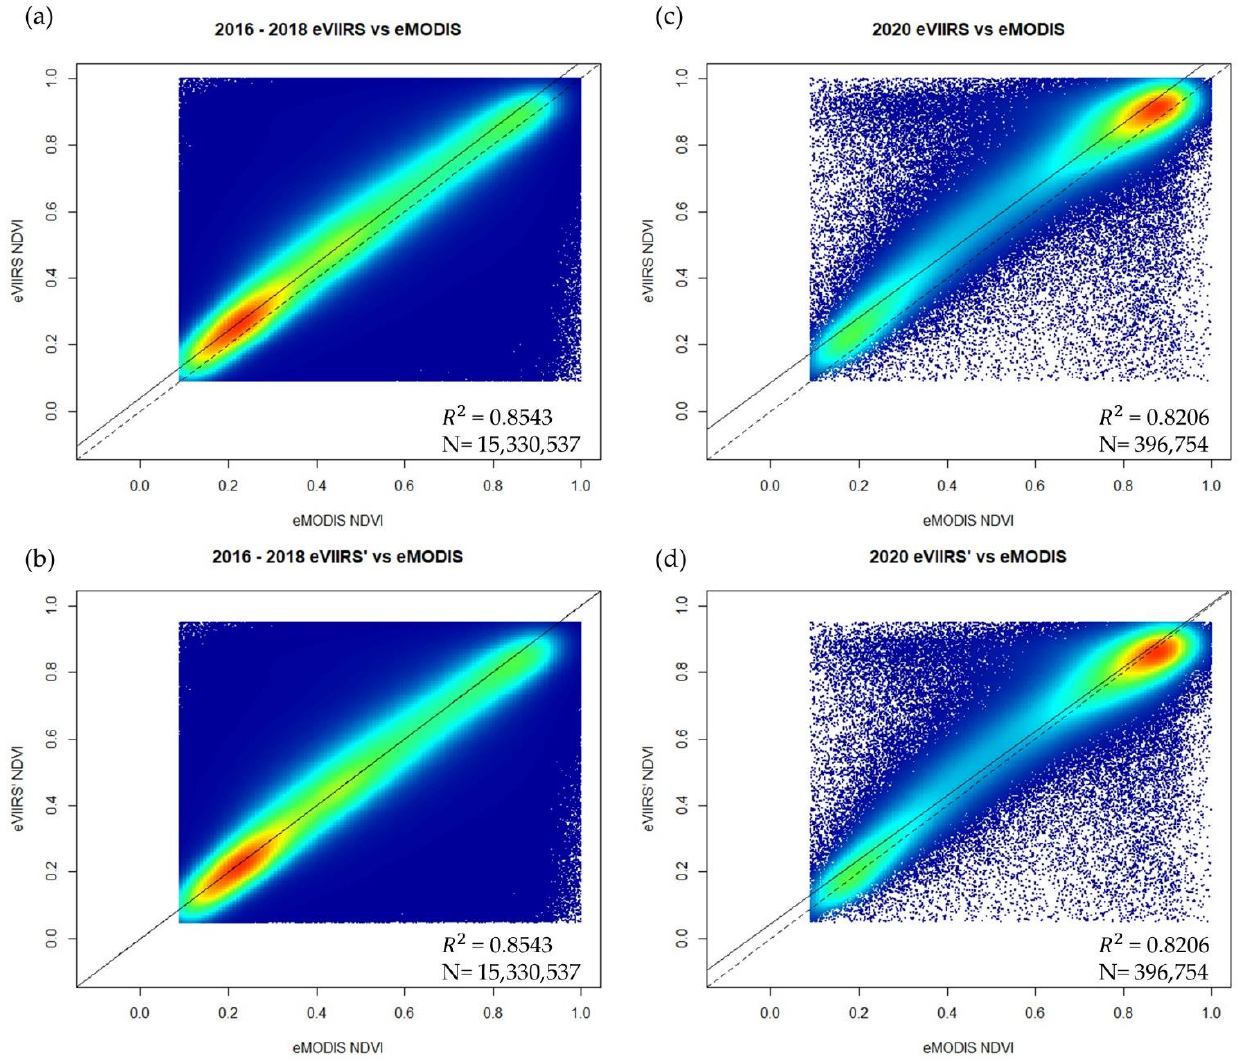
Figure 3. Expedited Visible Infrared Imaging Radiometer Suite (eVIIRS) and expedited Moderate Resolution Imaging Spectroradiometer (eMODIS) Normalized Difference Vegetation Index (NDVI) comparisons with all composites, ( a ) 2016– 2018 eMODIS NDVI vs. eVIIRS NDVI, ( b ) 2016–2018 eMODIS NDVI vs. eVIIRS’ NDVI, ( c ) 2020 eMODIS NDVI vs. eVIIRS NDVI, and ( d ) 2020 eMODIS NDVI vs. eVIIRS’ NDVI. The eVIIRS NDVI composites are 375-m and eMODIS NDVI composites are 250-m. The visual aspects of eVIIRS’ and eMODIS are shown in Figure 4, where the corresponding composite week’s comparisons are illustrated in Figure 4c,d. Point density increases from low (blue) to moderate (green) to high (red), the geometric mean regression (solid line) and the 1-to-1 line (dashed line).